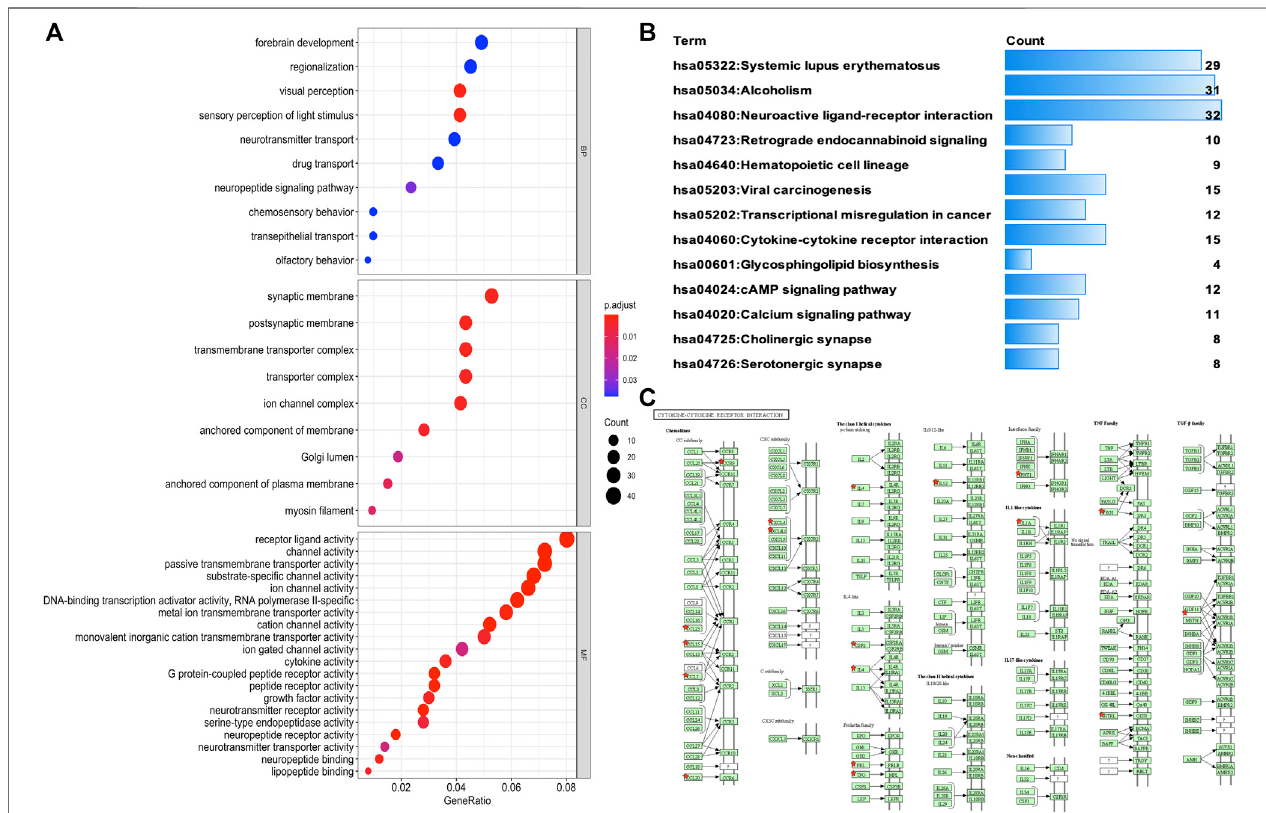
FIGURE 3 | Functional characteristics and pathway enrichment analysis of DEGs between immunotypes A and B in THYM. (A) GO analysis (including biological process, cellular component, and molecular function) of DEGs between immunotypes A and B in THYM. (B) KEGG pathway enrichment analysis of DEGs between immunotypes A and B in THYM. (C) Cytokine-cytokine receptor interaction pathway enriched in